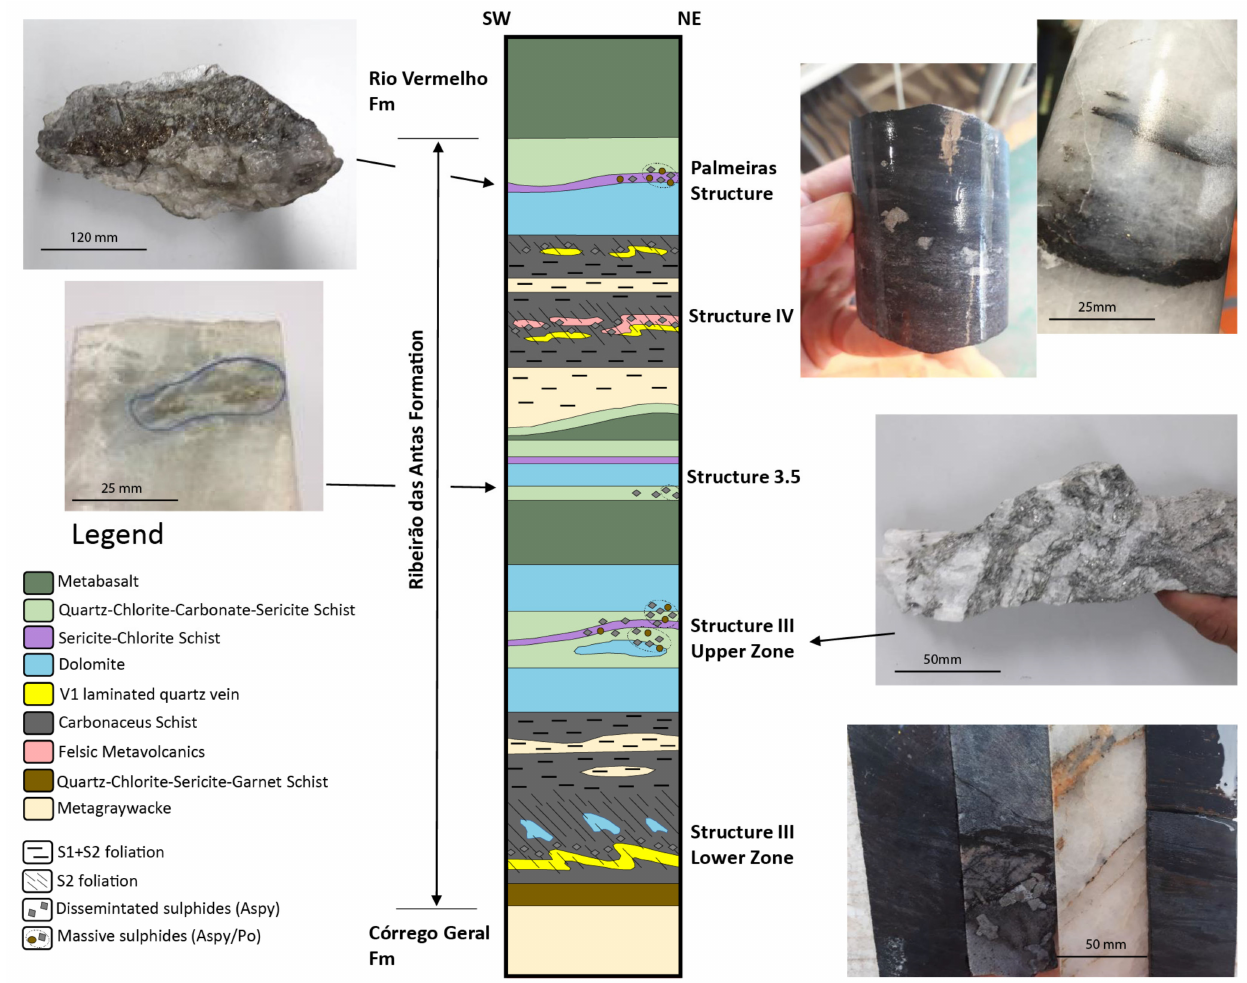
Figure 10. Schematic litho-structural column (not to scale) and examples of mineralization within individual